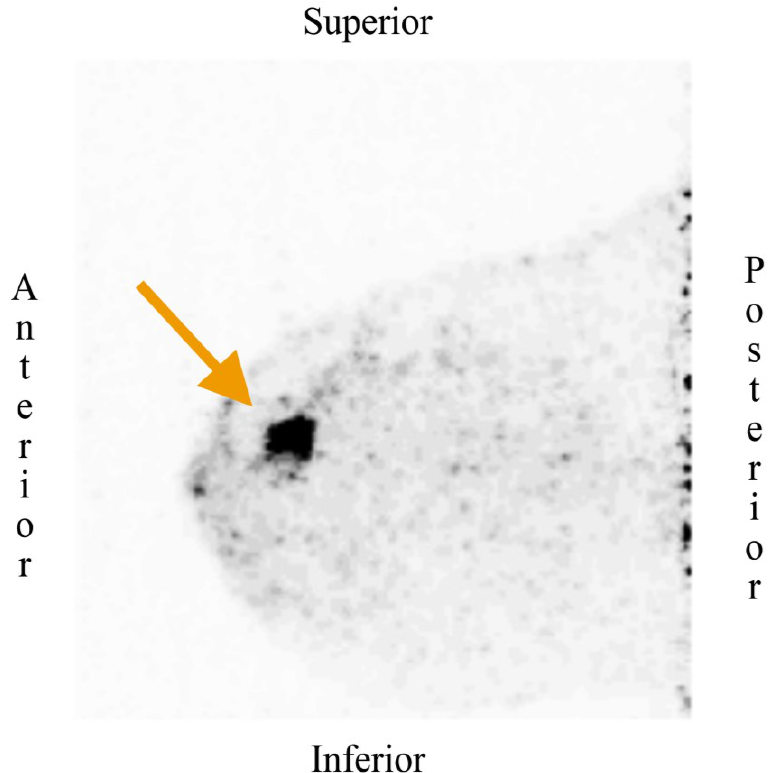
Figure 4. Recently diagnosed breast cancer in a middle-aged woman. The dedicated breast PET scan (MAMMI Breast PET, Oncovision, GEM Imaging SA, Valencia, Spain) shows a focus of intense FDG uptake (arrow) in the upper inner quadrant of the right breast that was proven to be a breast carcinoma. Image courtesy of Dr. Cozar-Santiago